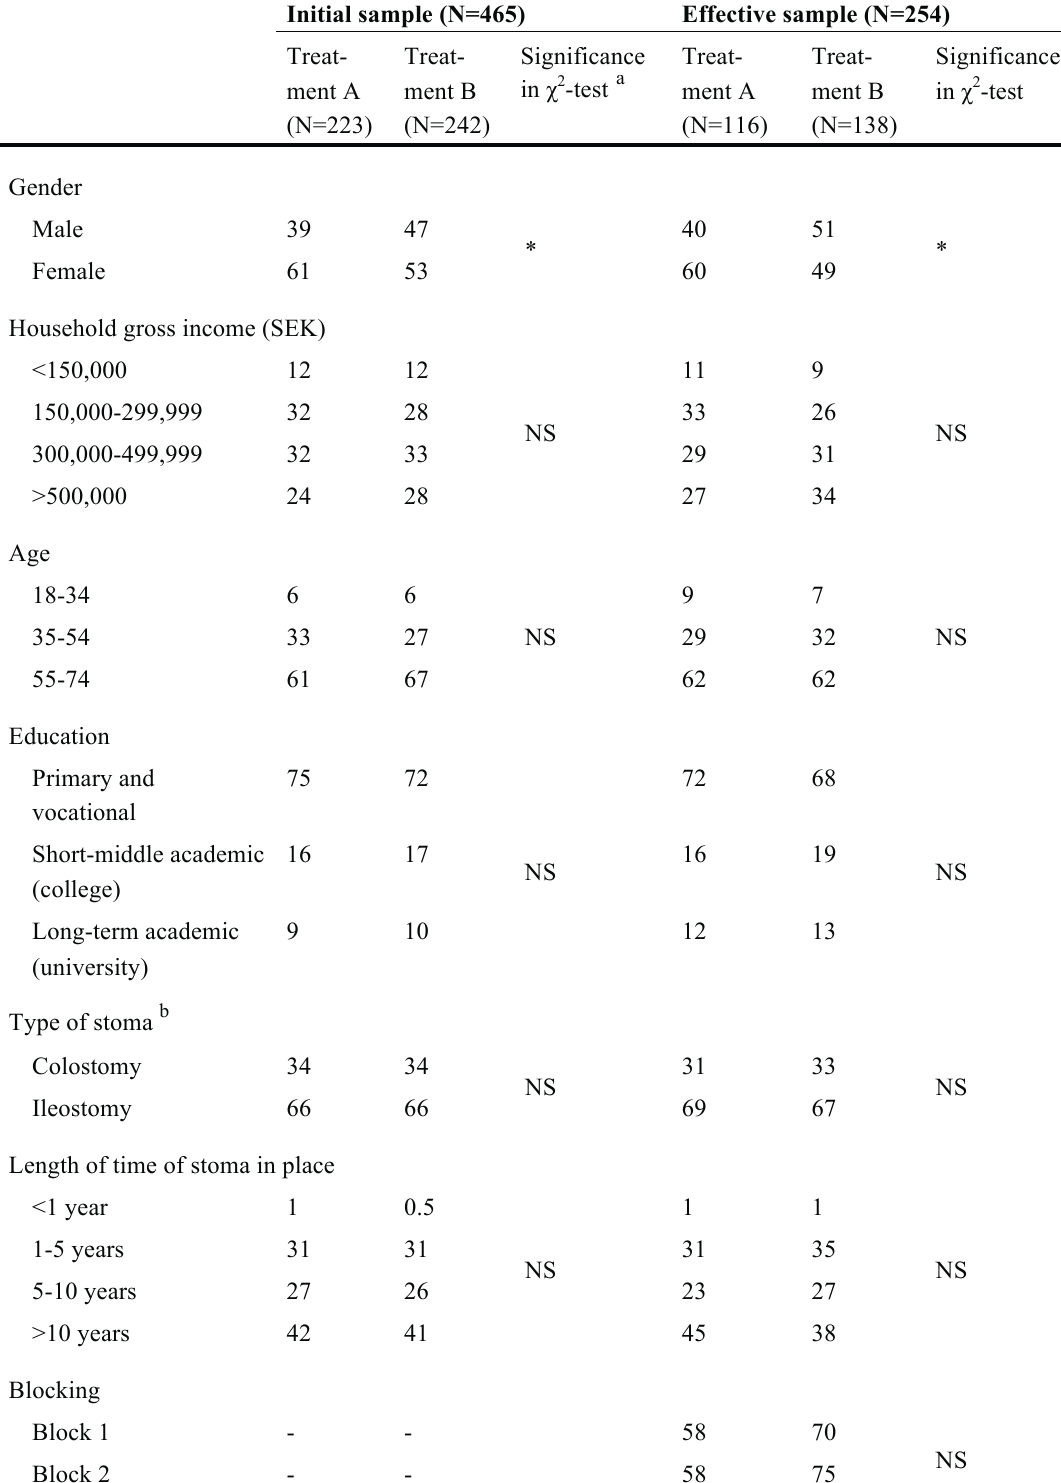
NS indicates no significant difference at 95 percent level, * indicates a significant difference at 95 percent level. a The χ 2-tests are employed on the basis of the actual numbers behind the percentages. b There are three types of stoma: Colostomy, ileostomy, urostomy. The sample does not contain ostomates with